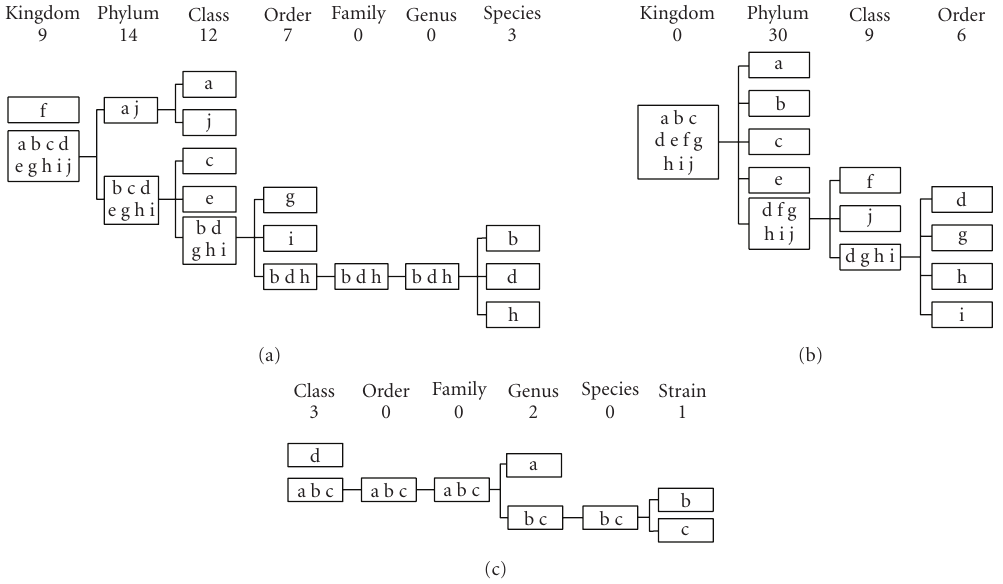
Figure 3: The taxonomy distribution of the 10 species in (a) Set 1, (b) Set 2, and the 4 species in (c) simMC Phrap. Each letter represents a single species. The numbers below the taxonomic levels indicate the maximum number of mixed pairs at that taxonomic level. For example, in (a), the maximum number of mixed pairs at taxonomic level of Class is 12, which consists (a,j), (c,e), (c, { b,d,g,h,i } ), and (e, { b,d,g,h,i } ) mixed pairs.